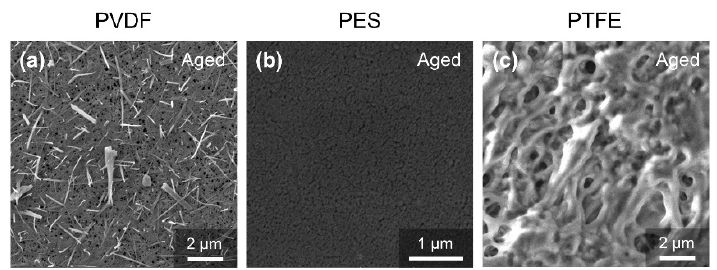
Figure 6. SEM photograph of the pristine membrane and aged (five-years equivalent) membrane in the alkaline oxide aging test. ( a ) Aged PVDF membrane, ( b ) aged PES membrane, ( c ) aged PTFE membrane.